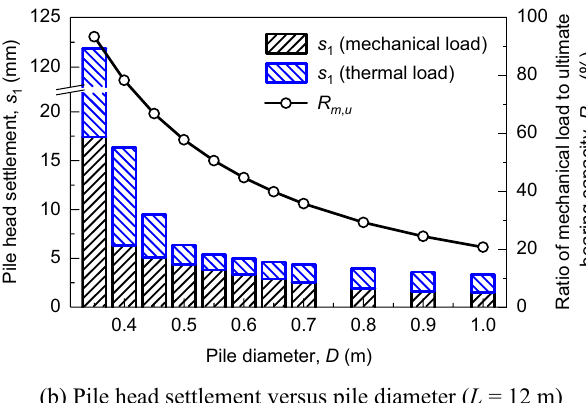
Figure 4. Performance of energy piles in different design